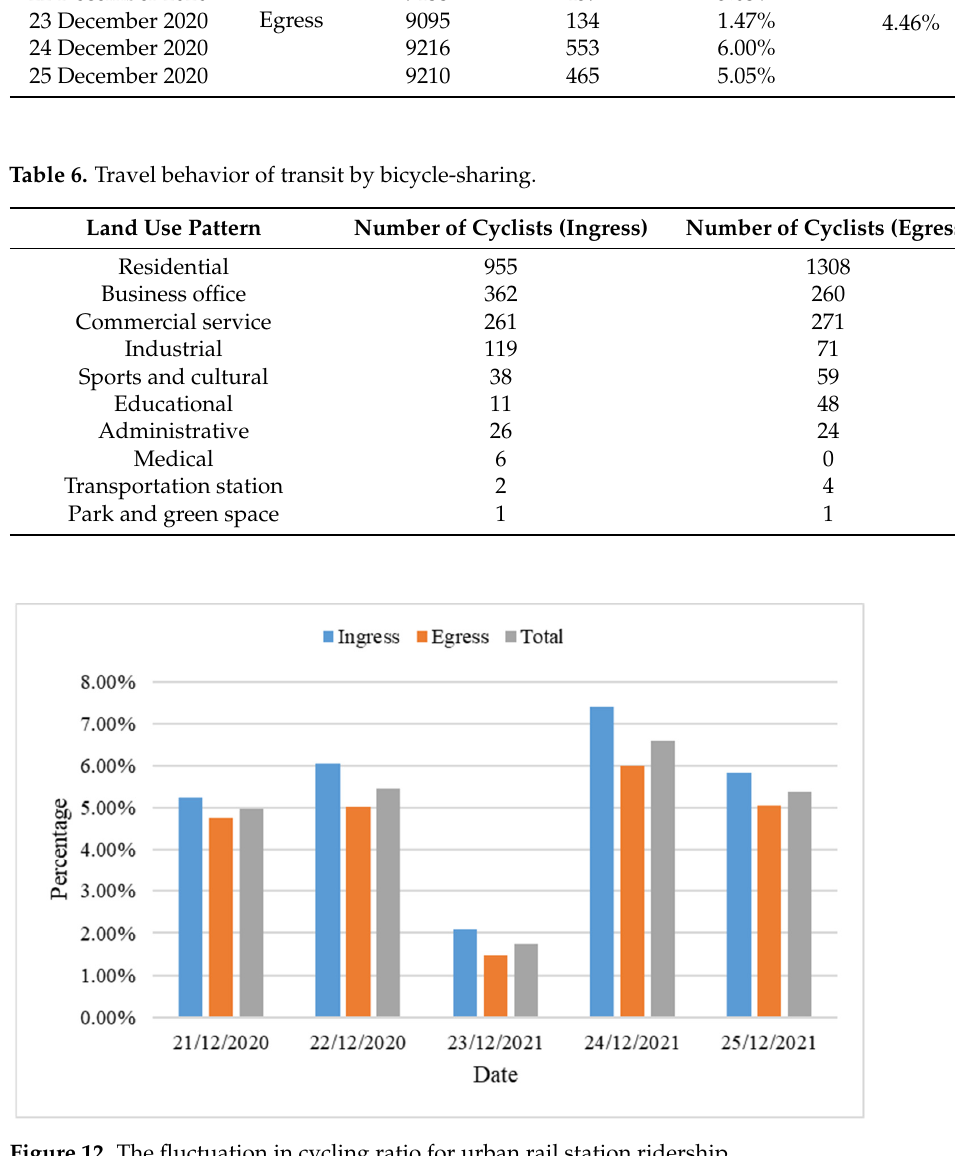
Figure 13. The fluctuation in cycling ratio for land use pattern. 5.2. Results of Correlation Analysis This paper selected six types of land use pattern as the variable to measure the cor ‐ relation between urban rail ridership and land use pattern in an attempt to improve the efficacy of modeling, with the variable ‐ explained value nearly doubling when all land use patterns were considered. Urban rail ridership is significantly influenced by land use pat ‐ terns, which explains why egress ability outperforms ingress. Regarding urban rail station egress ridership, the land use pattern could explain 48.46% of egress ridership during the 6:00–10:00 a.m. period, while the land use pattern could account for 36.88% of ingress rid ‐ ership during the same period. As shown in Table 7, the variables have differing effects.